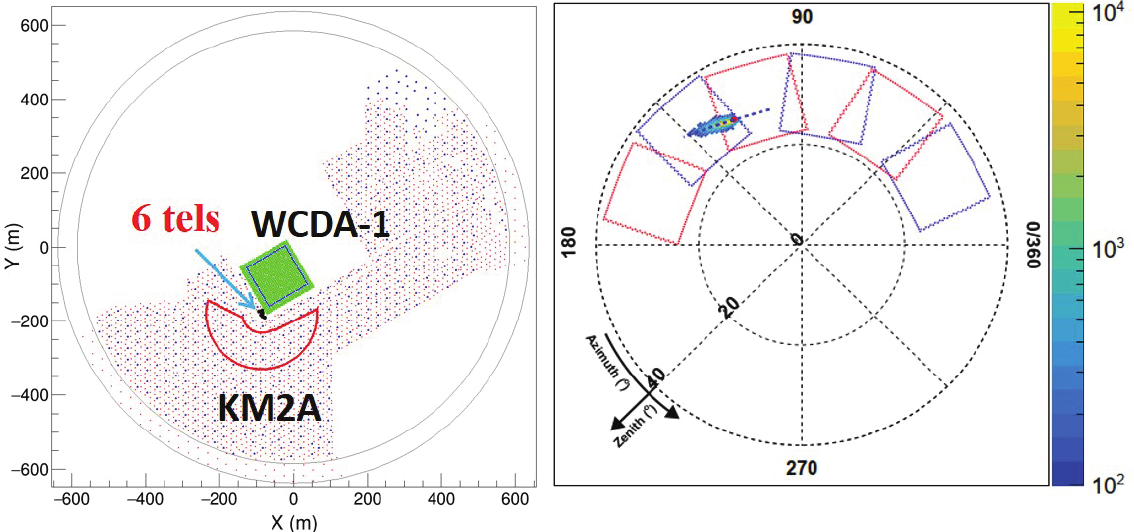
Figure 2. The configuration of LHAASO hybrid operation for cosmic ray observation before April 2021. The layout of all detectors is shown in the leftt panel. The FoV of the 6 WFCTs is shown in the right panel in the polar-coordinate system where the radius indicates the zenith angle and the polar angle in counterclockwise indicates the azimuth angle. Each square indicates the corresponding FoV of the telescope. There are overlaps between the adjacent FoV’s. An image of a shower is also shown in the